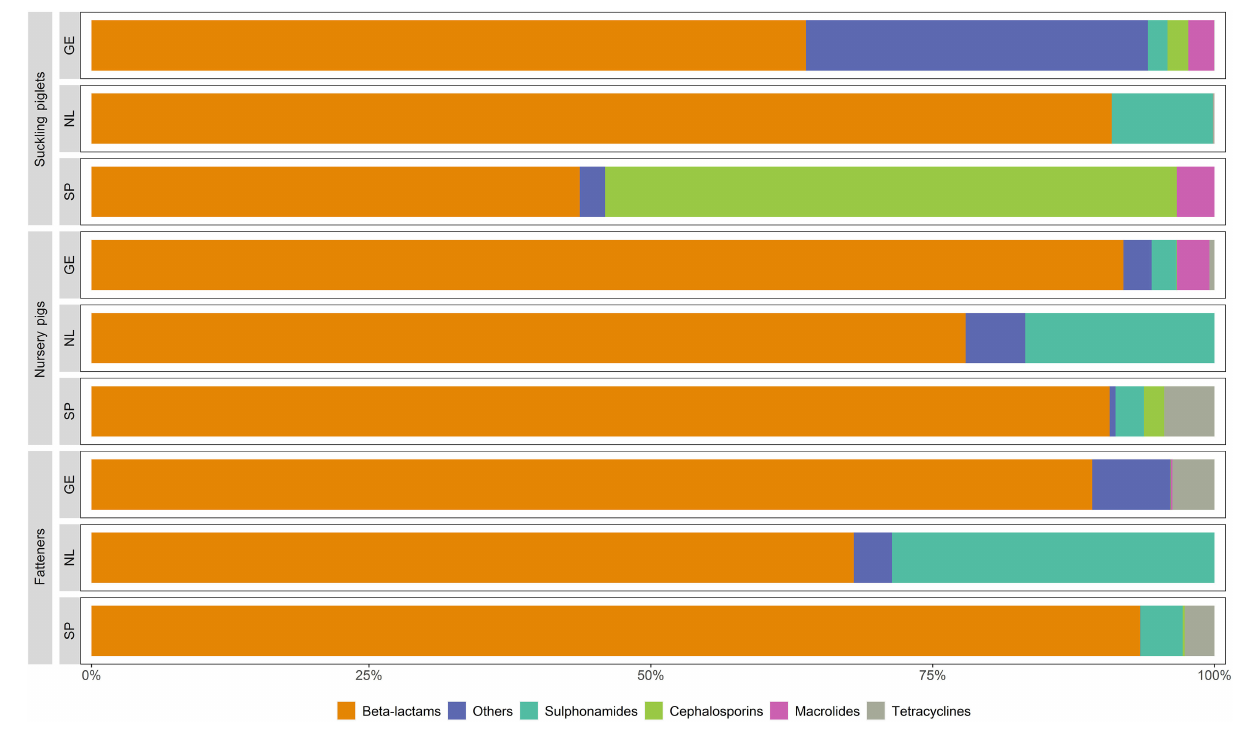
prevalent in the countries of study, results in a higher incidence of S. suis -disease and more severe lesions (30,